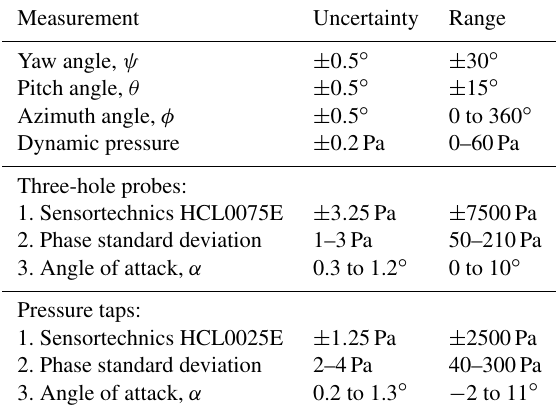
Table 2. Measurement uncertainty summary. Measurement